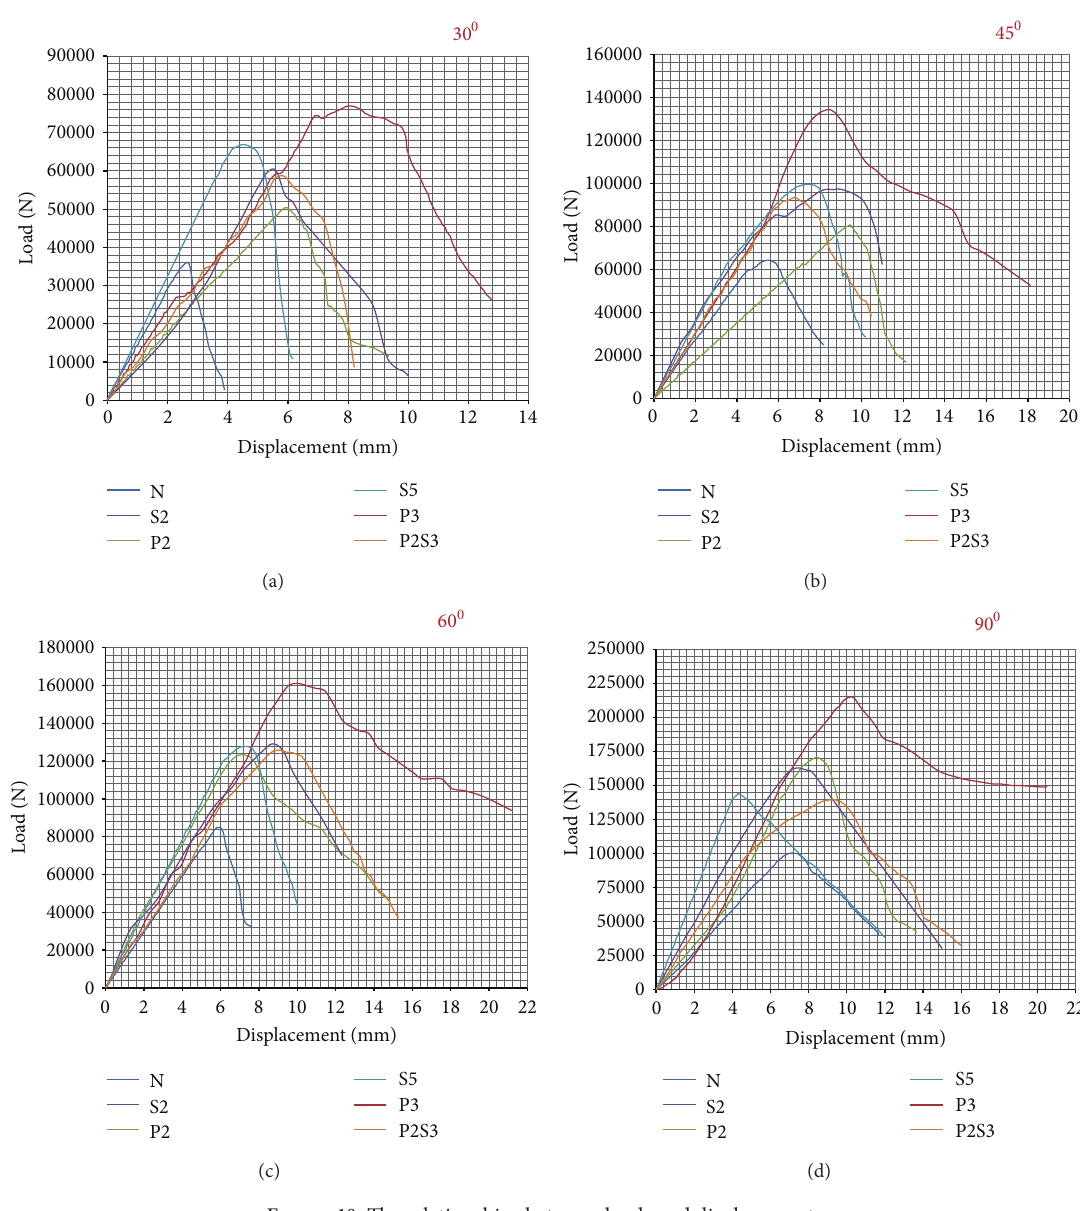
Figure 10: The relationships between loads and displacements. samples are ruptured in the inner structure, the polypropy- lene fiber plaster crust swells and takes damage in Figure 12. The highest deformation ability is observed in polypropy- lene fibered and then the steel fibered walls. The normal plastered samples have shown a lesser deformation ability compared to the reinforced plasters. The amounts of energy consumed by the samples during the experiment were cal- culated using the area below the load-displacement curves of the samples. Area values for the wall samples used in the study are given in Table 6. In the area calculation, the areas under the parts reaching the 0,85 and 0,50 levels of the maximum load level on the decreasing arm of the load- displacement curve were taken into consideration. In Table 6, the values belonging to the reinforced samples are given Figure 11: The deformation ability of the samples.